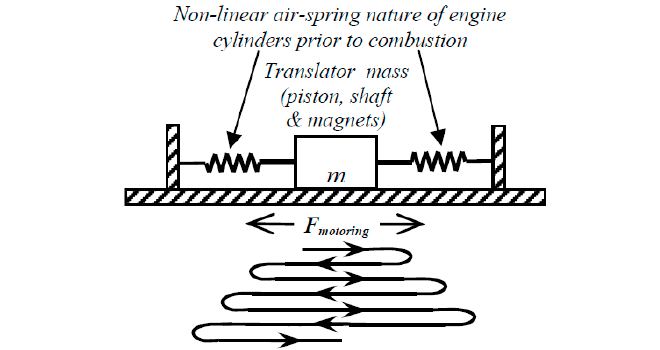
Figure 17. Spring mass representation and mechanical resonance for FPLG starting [42].